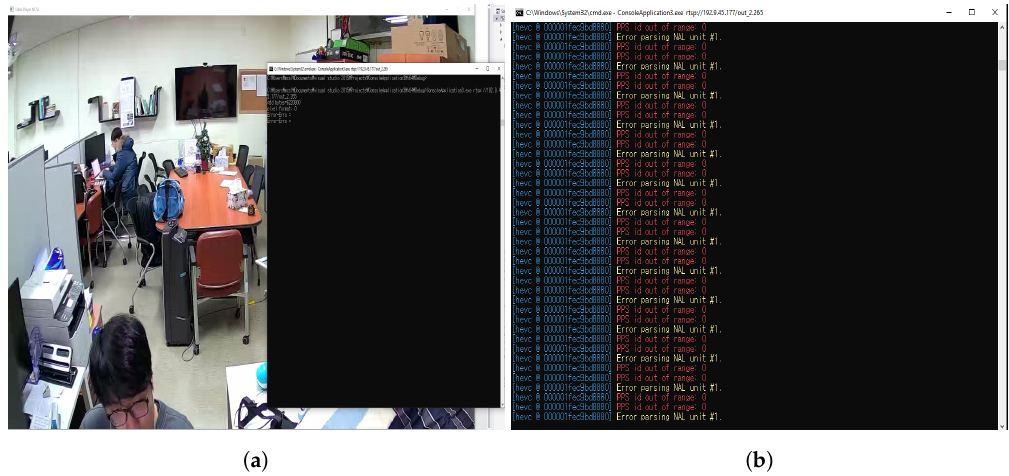
Figure 18. Video client decrypts encrypted CCTV video bitstream: ( a ) with correct keys; and ( b ) without correct